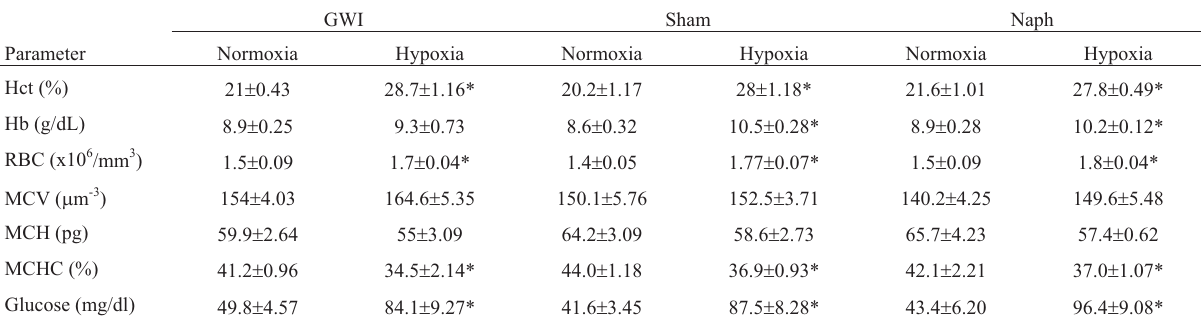
Table 1 - Hematological parameters levels in C. macropomum in the groups without injection (GWI), with corn oil injection (Sham) and naphthalene in- jection (Naph) after 96 h to normoxia exposure followed by 6 h of hypoxia. *Indicates statistical difference between normoxia and hypoxia of the same treatment. Significance value p